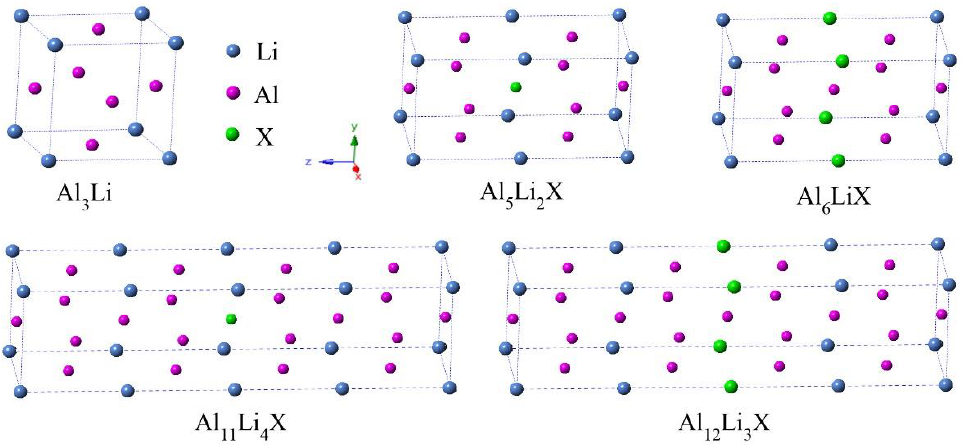
Figure 1. Crystalline structures of Al 3 Li doped with alloying element X (X = Sc, Ti, Co, Cu, Zn, Zr, Nb, and Mo) at different alloying concentrations of 6.25 and 12.5%.